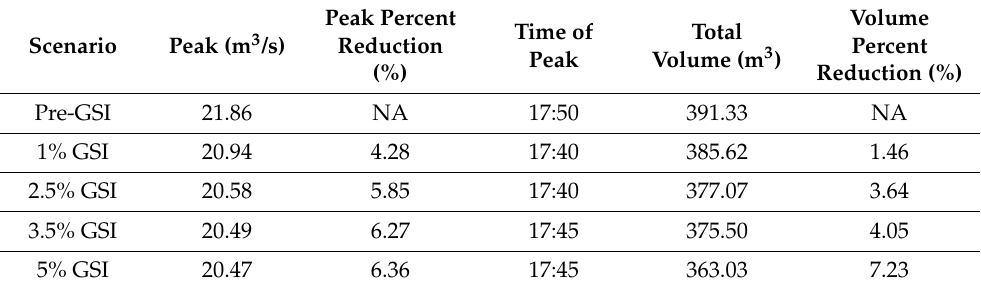
Figure 3. Overall flood extent and distribution of depths for the pre-GSI scenario during the peak flood extent at 18:30 MDT on 24 June 2015, with flood-related resident reports (service requests) from 10 August 2009 to 25 November 2019 made to the City and County of Denver Department of Public Works and DPW-identified recurring flood locations. Table 5. Peak streamflow reduction (from pre-GSI), peak streamflow timing, and total streamflow volume reduction for the four GSI scenarios in comparison to the pre-GSI